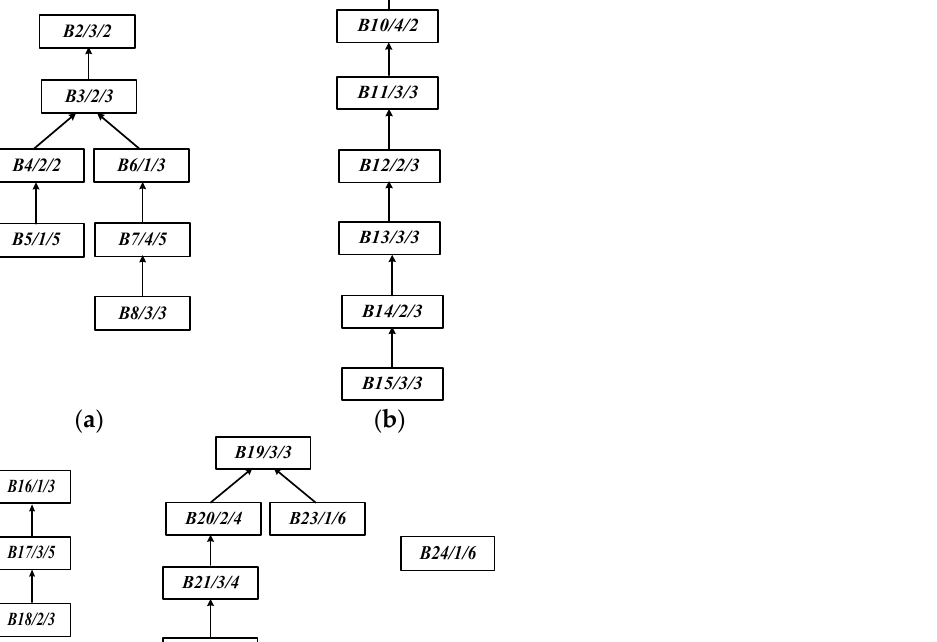
Table 1. Equipment priority statistics of complex product